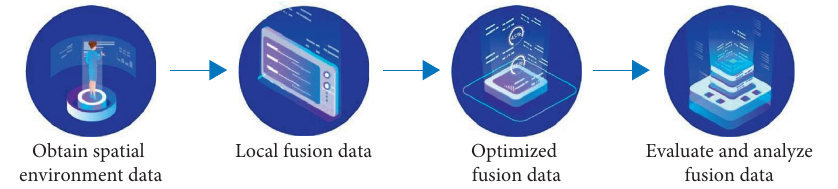
Figure 1: Sequence multiscale feature